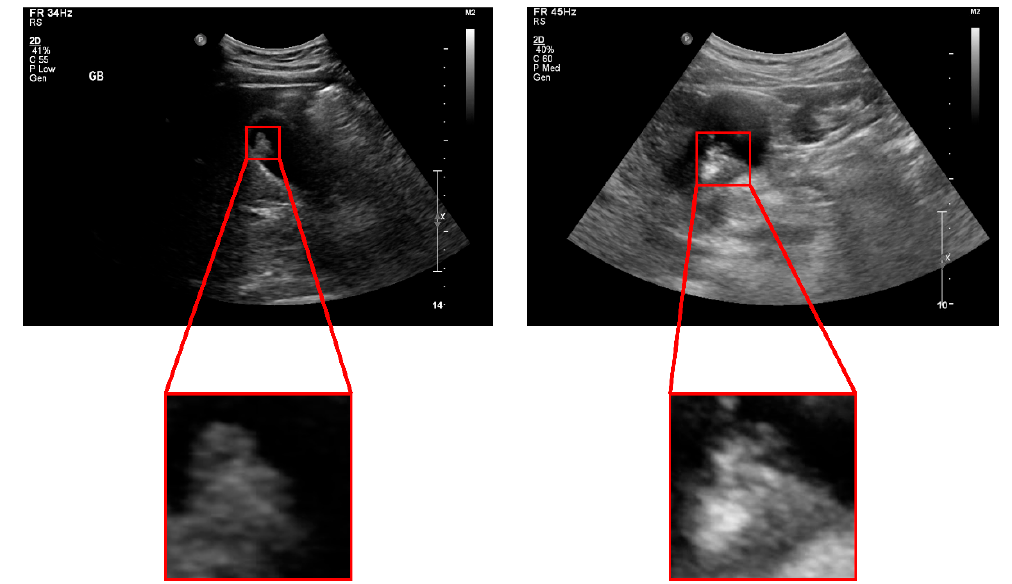
Figure 1. Examples of cropped images. We manually cropped the polyp area from each gallbladder ultrasonography image with a one-to-one ratio. All cropped images were resized to the same size for deep learning analysis.